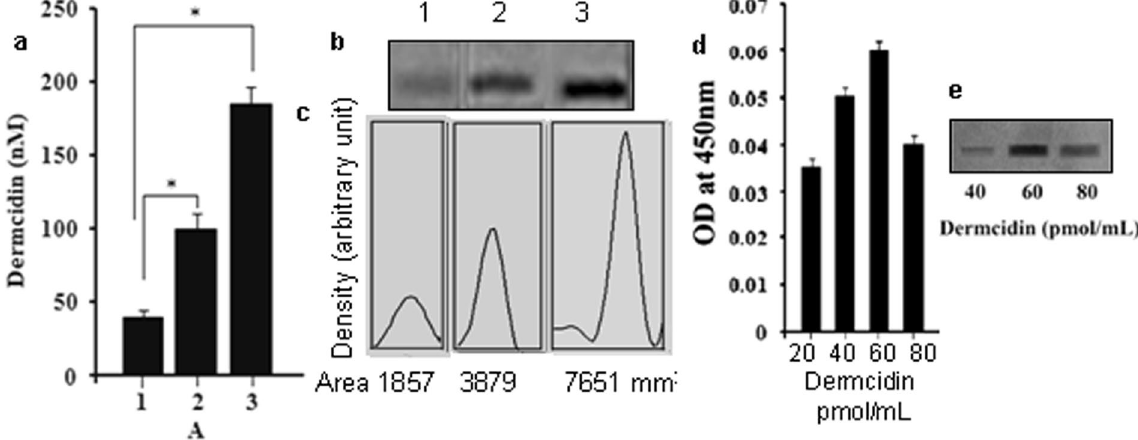
Figure 1. Identification of dermcidin in the cell free plasma of both normal and type-1 diabetes mellitus patients. The cell free plasma from both normal and diabetic patients was prepared as described in the Materials and Methods section. The amount of dermcidin was determined by ELISA by using polyclonal antibody raised against the purified dermcidin. Panel-a: Solid bar ‘1’ represents the dermcidin level in normal subject. Solid bar ‘2’ and ‘3’ represents the dermcidin level in T1DM patients with blood glucose level in between 120–340 mg/ dL and > 340 mg/dL respectively. Panel-b: Immunoblot analysis of the plasma level of dermcidin in normal and T1DM subjects. ‘1’ represents the dermcidin band in the cell free plasma (CFP) of normal subject. ‘2’ and ‘3’ represents the dermcidin bands in the CFP of T1DM subjects with blood glucose level in between 120–340 mg/ dL and > 340 mg/dL respectively. Data are mean ± S.D. of at least 10 different experiments using 10 different samples from 10 different volunteers (Male = 5, Female = 5) ( * represents p < 0.05). Panel-c: Integrated area of each of the immunopositive band as shown in the Panel-b. Panel-d: A standard bar diagram of ELISA assay for pure dermcidin protein. Dermcidin was purified by repeated gel electrophoresis as described. The